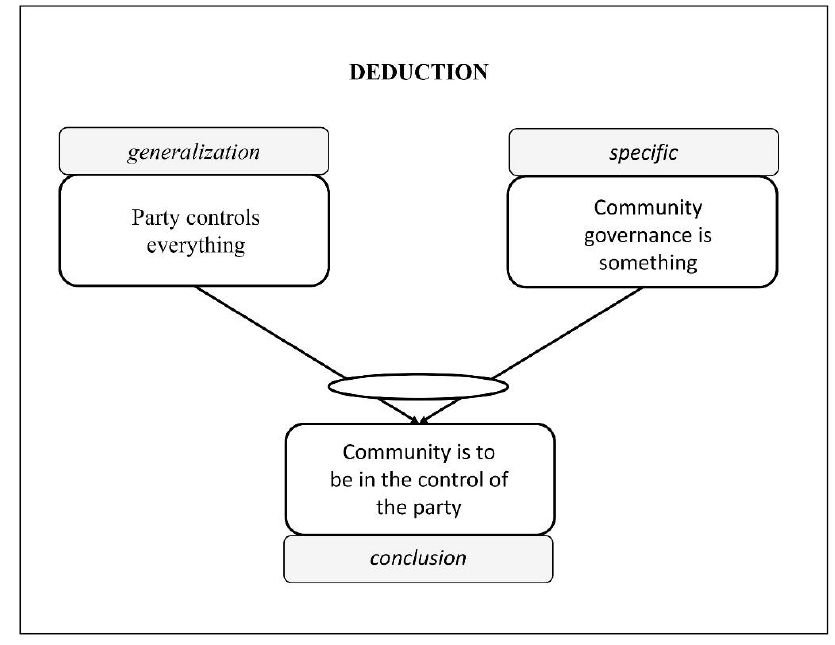
Fig 9. The modern embodiment of community governance inertia as a paradigm (developed by the authors, based on CPC,